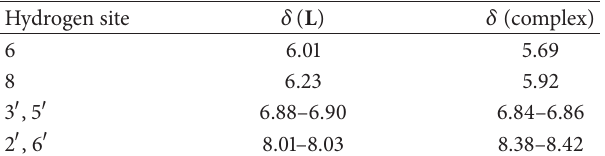
Table 1: 1 H NMR chemical shift differences between L and the complex.